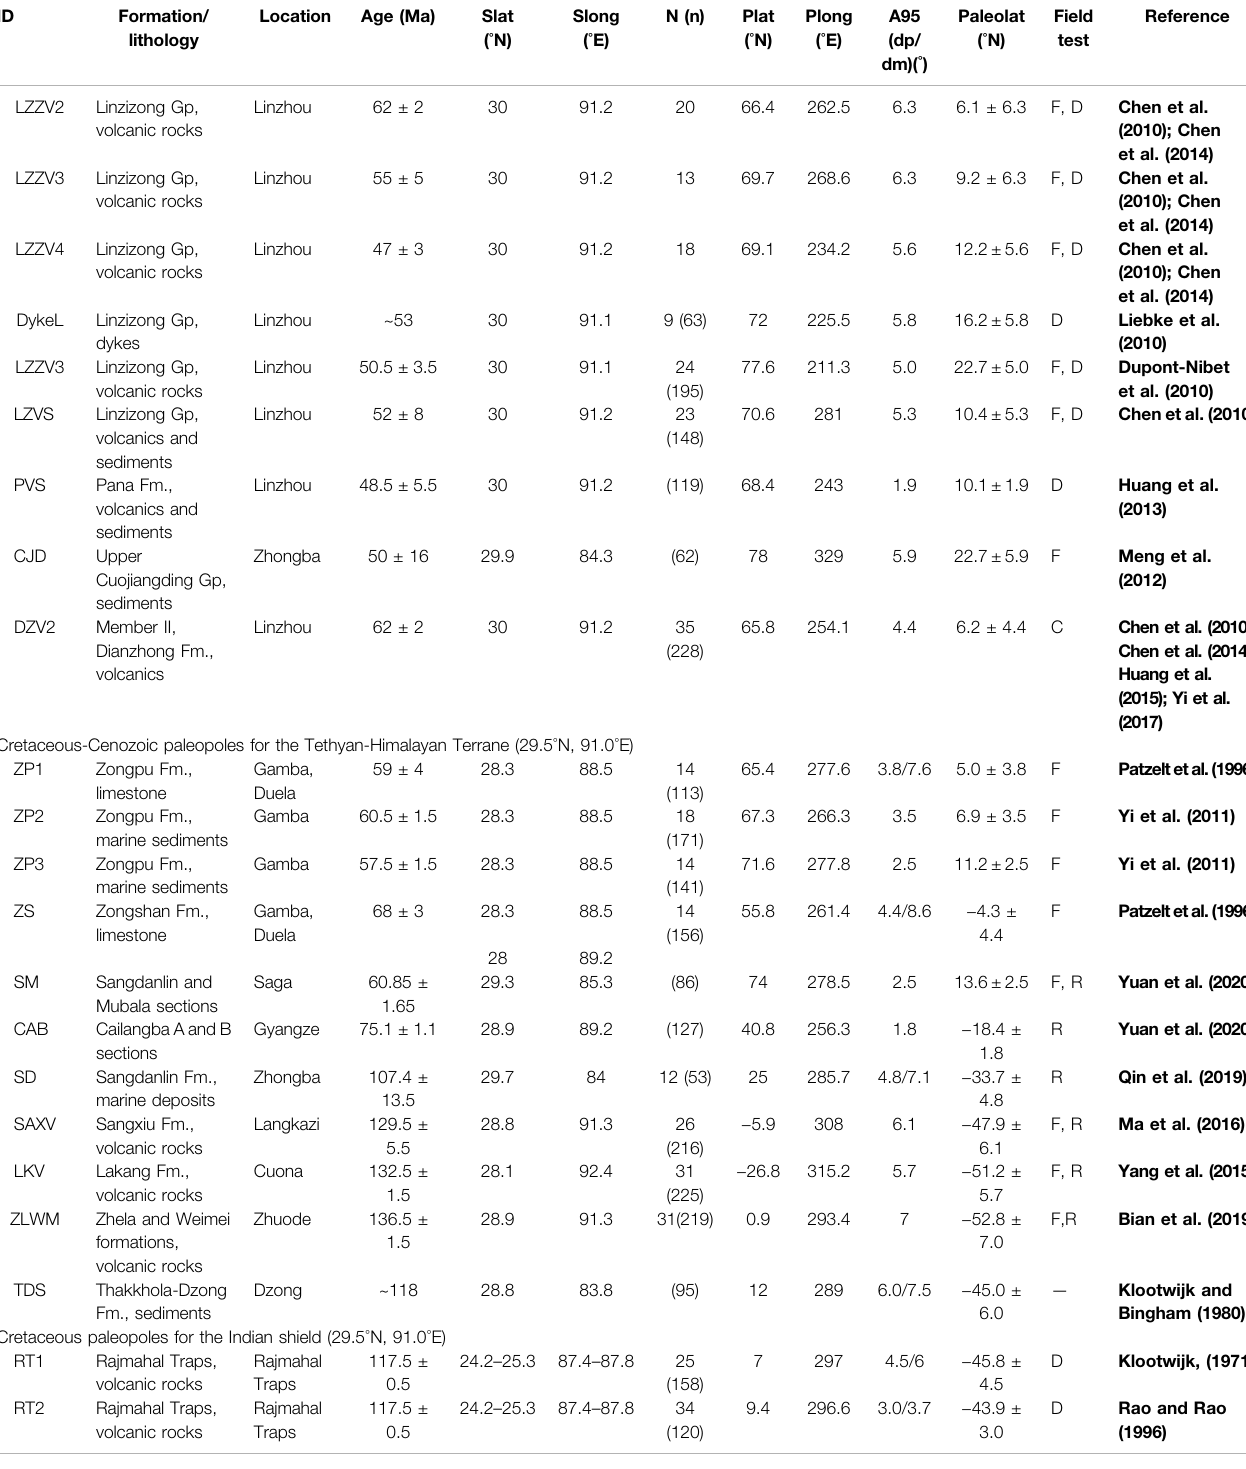
TABLE 2 | ( Continued ) Summary of Cretaceous and Early Cenozoic paleomagnetic poles from the Lhasa and Tethyan-Himalayan (two are from interior of Indian craton) terranes. ID